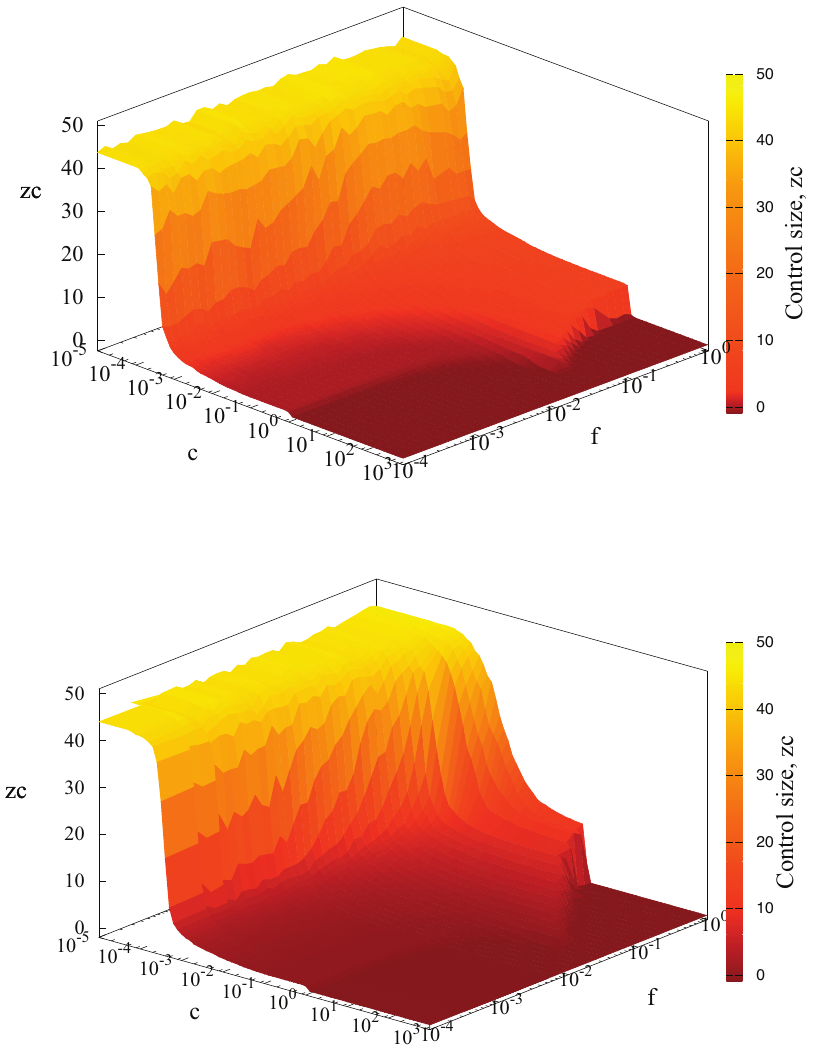
Figure 3. Control neighborhood size as a function of treatment cost c and infectiousness of the disease f for regular network and small world model. Simulation parameters: q ~ 0 : 5, v , r ~ 0 : 1, with 40 initial foci and z inf ~ 1 : Control size z c w 0 represents local strategy (LS), z c ~ 0 corresponds to the strategy when only the detected individual is treated and z c § 30 denotes GS (more than 99% of individuals are treated). Null strategy corresponds to z c ~{ 1 : Top figure denotes results for disease spreading on regular networks, whereas bottom to small world model with inclusion of additional 2000 number of long range links (5%).